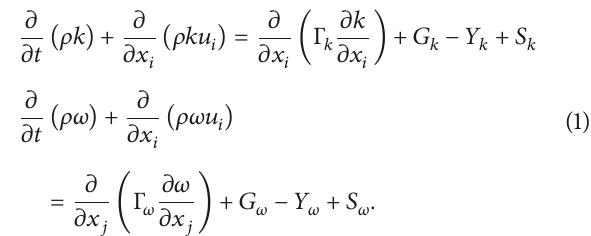
solution mode was adopted. The flow field characteristics were described by some calculated turbulent parameters like turbulent intensity, turbulent kinetic energy, turbulent scale, and turbulent dissipation rate apart from velocity and